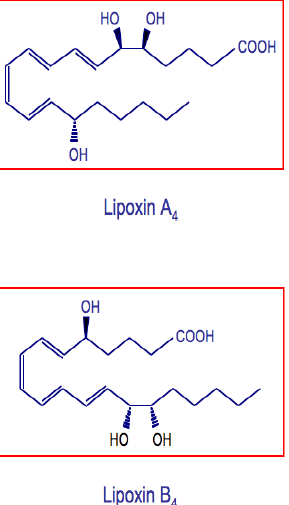
FIGURE 1. Chemical structures of lipoxin A 4 and B 4